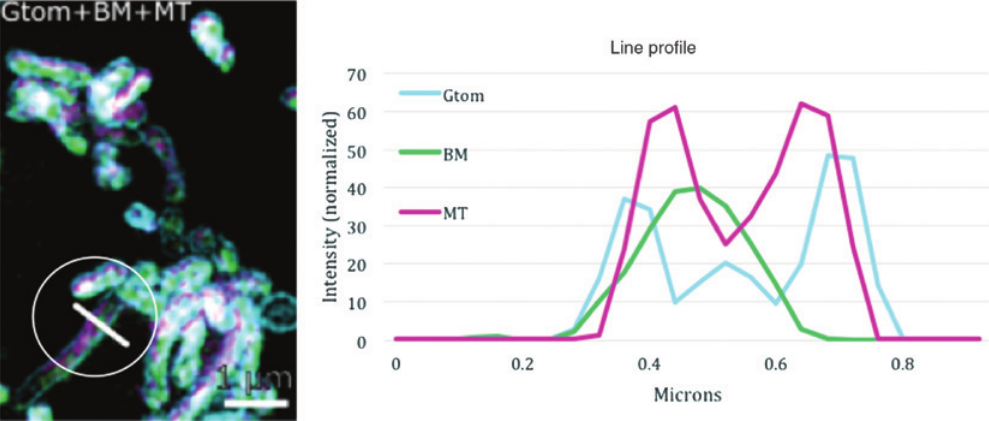
Figure 6: Cross-section of a triply labeled mitochondrion as indicated in Figure 5E and on the left panel. The plotted intensities have been normalized to the maximum intensity of each individual color channel. Here, BM shows a single peak con- tained amid the double peaks formed by both MT and Gtom. The width (FWHM) of the blue peaks is around 120 nm, reflecting the expected lateral resolution of the green channel (ex. 488